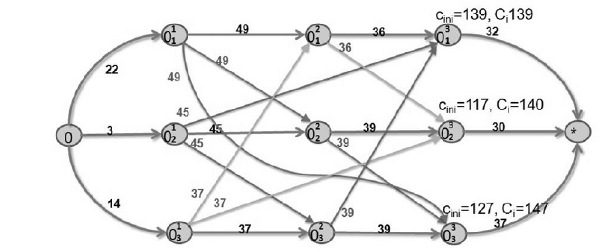
Fig. 2. Mixed graph ),,(= EAQG for three trains Fig. 3. Directed graph )( GG